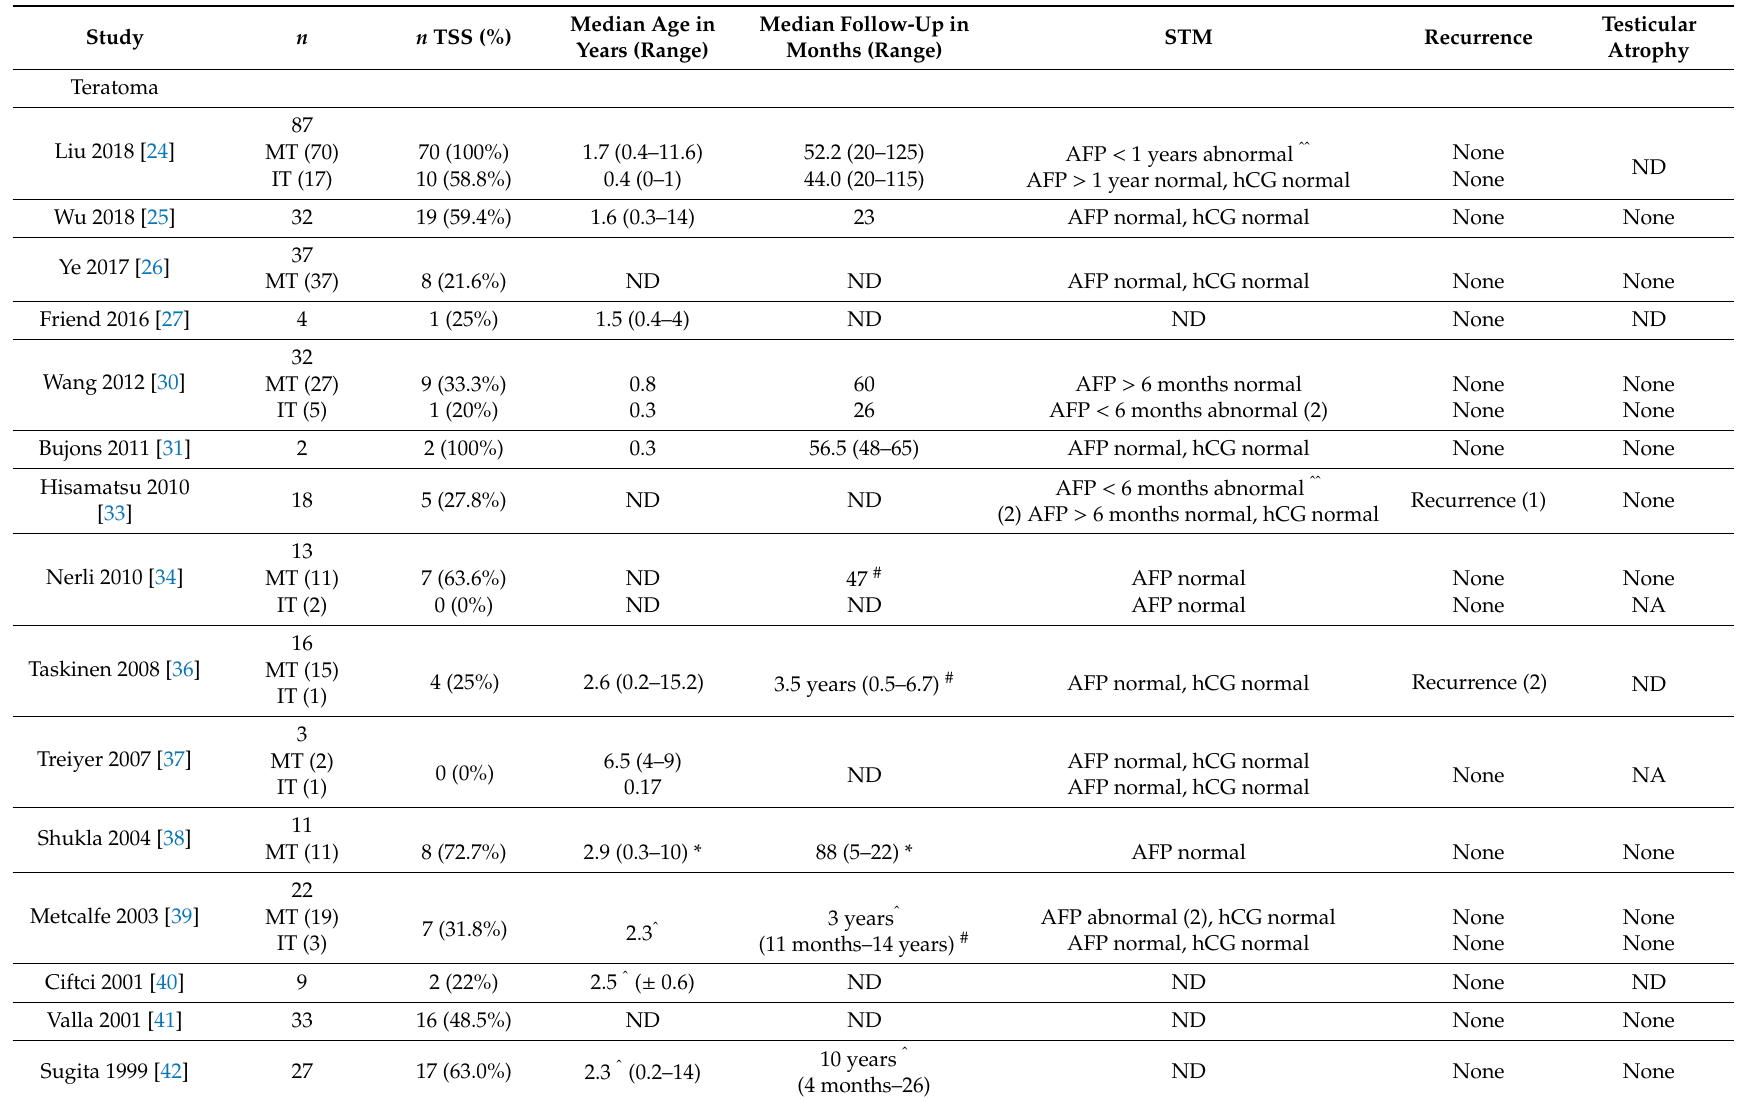
Table 2. TSS in benign testicular germ cell